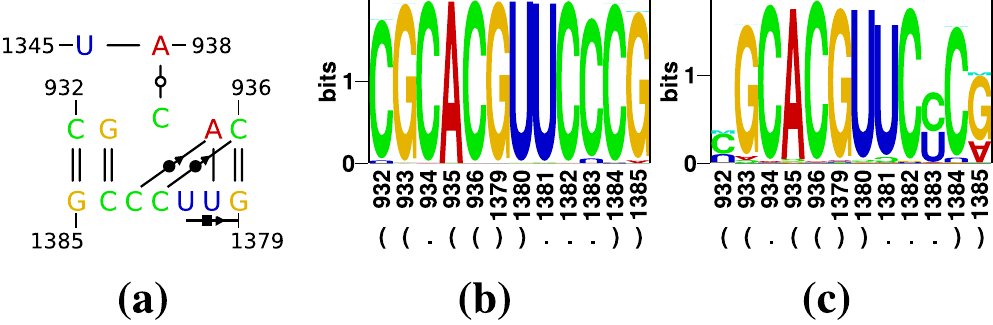
Figure 6. A motif from Thermus thermophilus 16S ribosomal RNA. ( a ) Nucleotides 932–936 and 1379–1385 are similar in sequence to IL2 of PSTVd; interactions are extracted by x3dna-dssr from PDB 1FJG 78 . ( b ) A logo of the motif ( a ) from an alignment of 23,500 bacterial 16S ribosomal RNAs 54 . ( c ) A logo of the motif ( a ) for 1850 sequences from the same alignment as used in ( b ), but sequences identical to the consensus 5 ′ CGCAC/ GUUCCCG 3 ′ were removed. Columns with less then 1% of nucleotides and sequences not fully spanning the motif or containing nucleotides other then [AUCG] were removed from the alignments used for the